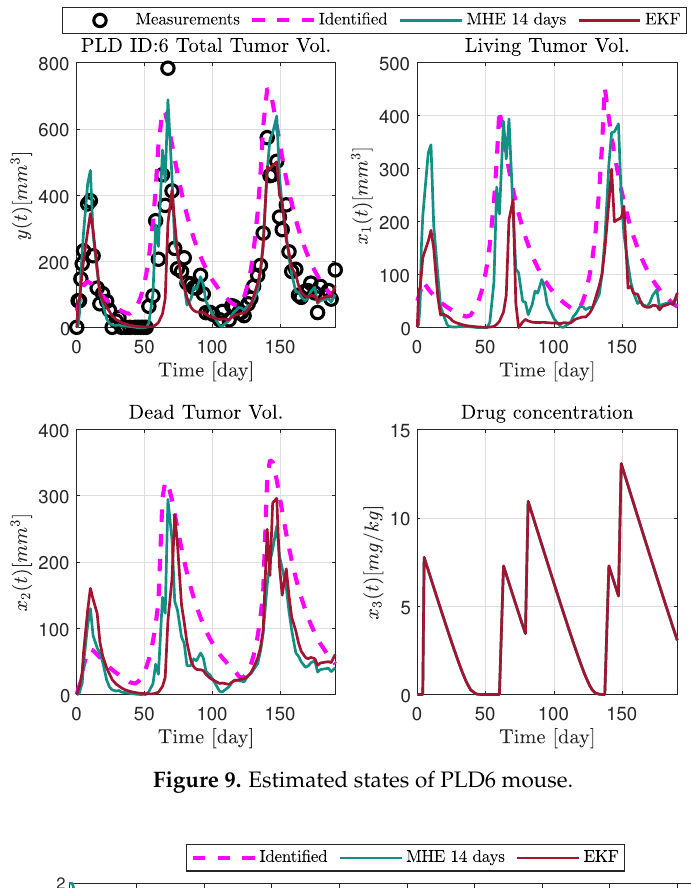
Figure 9. Estimated states of PLD6 mouse.